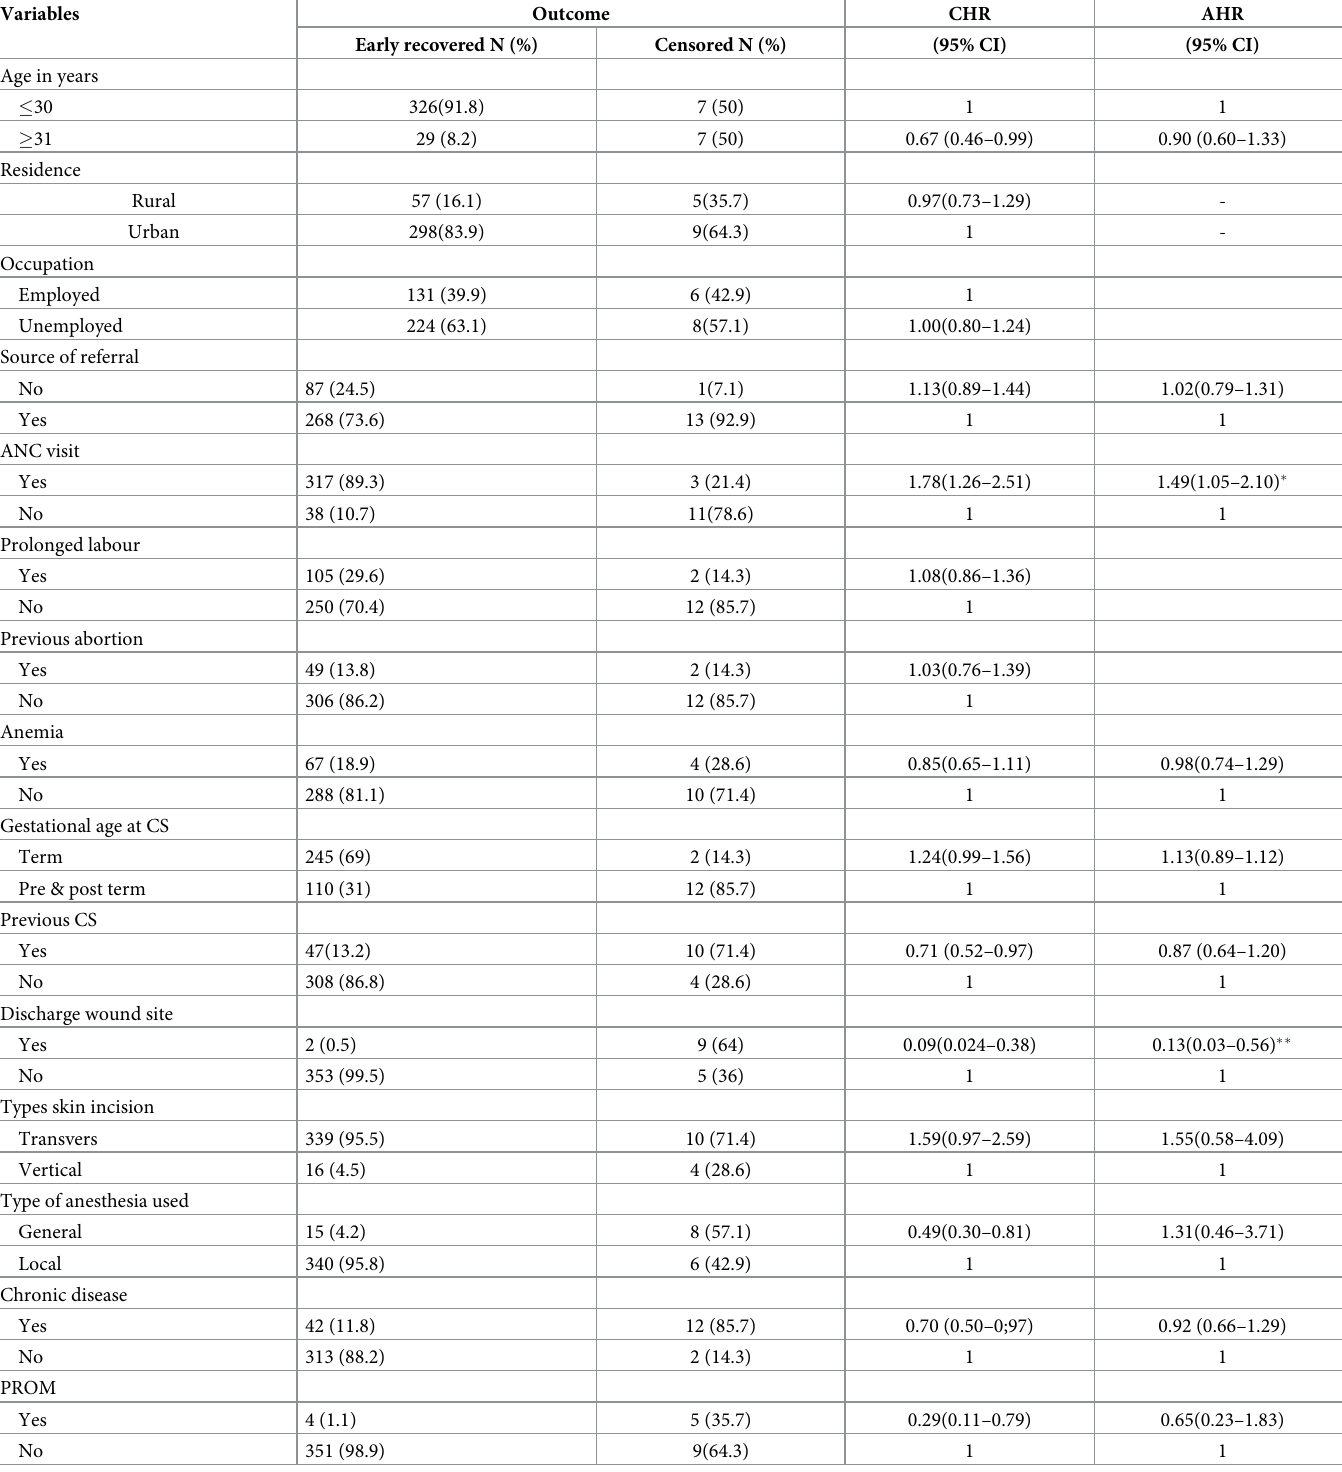
Table 5. Output of bivariable and multivariable Cox regression analyses on factors associated with time-to-recovery after CS delivery among women who gave birth by CS delivery at HUCSH,